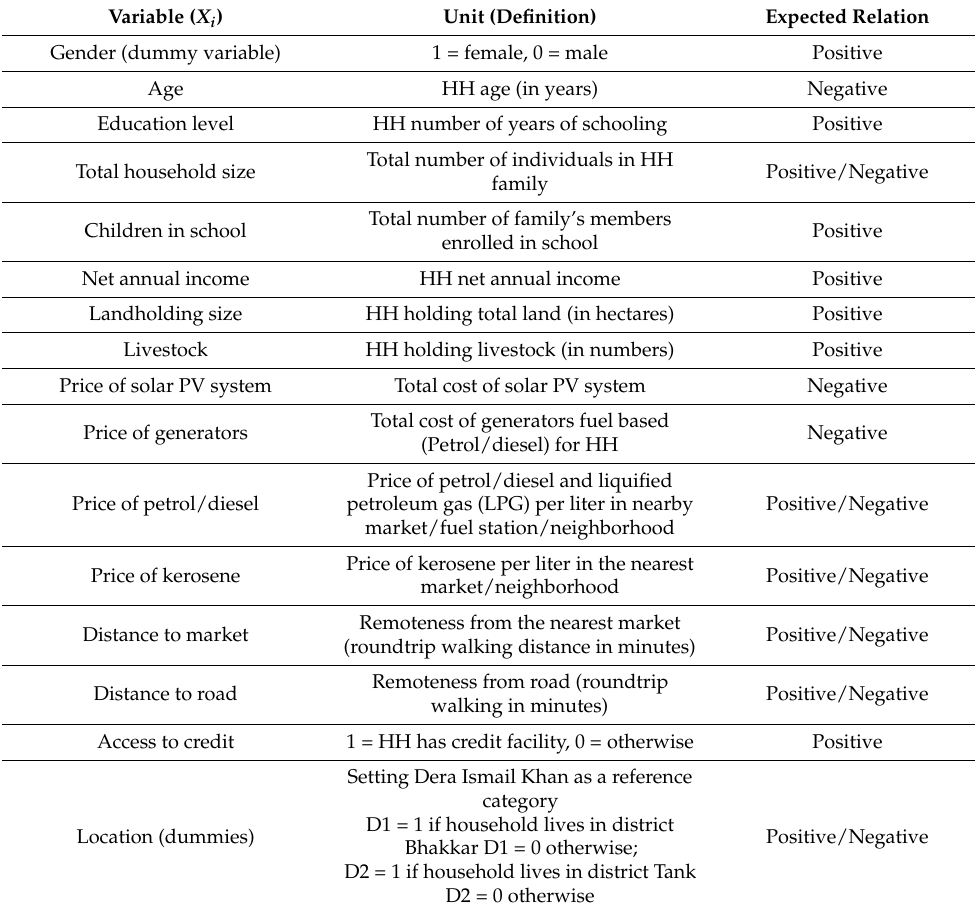
Table 1. Explanatory